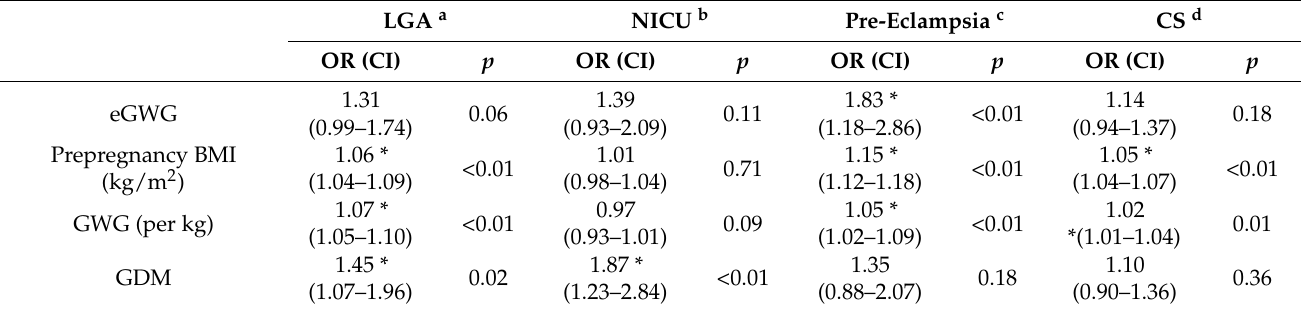
Table 2. Adjusted odds ratios (ORs) for perinatal